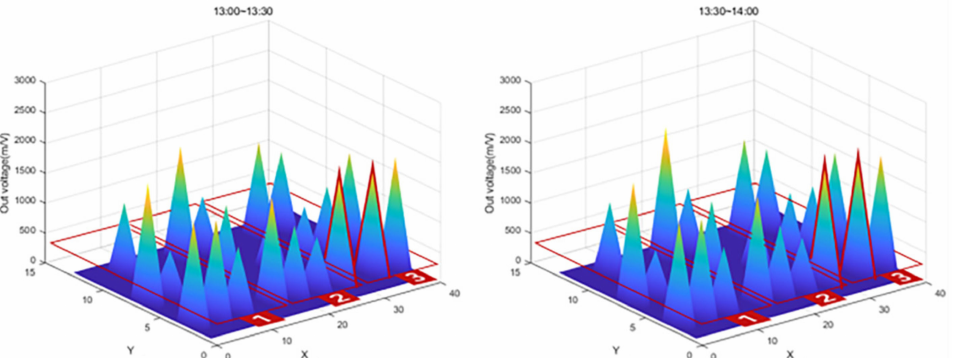
Figure 30. Sum of 3D graph values for data from